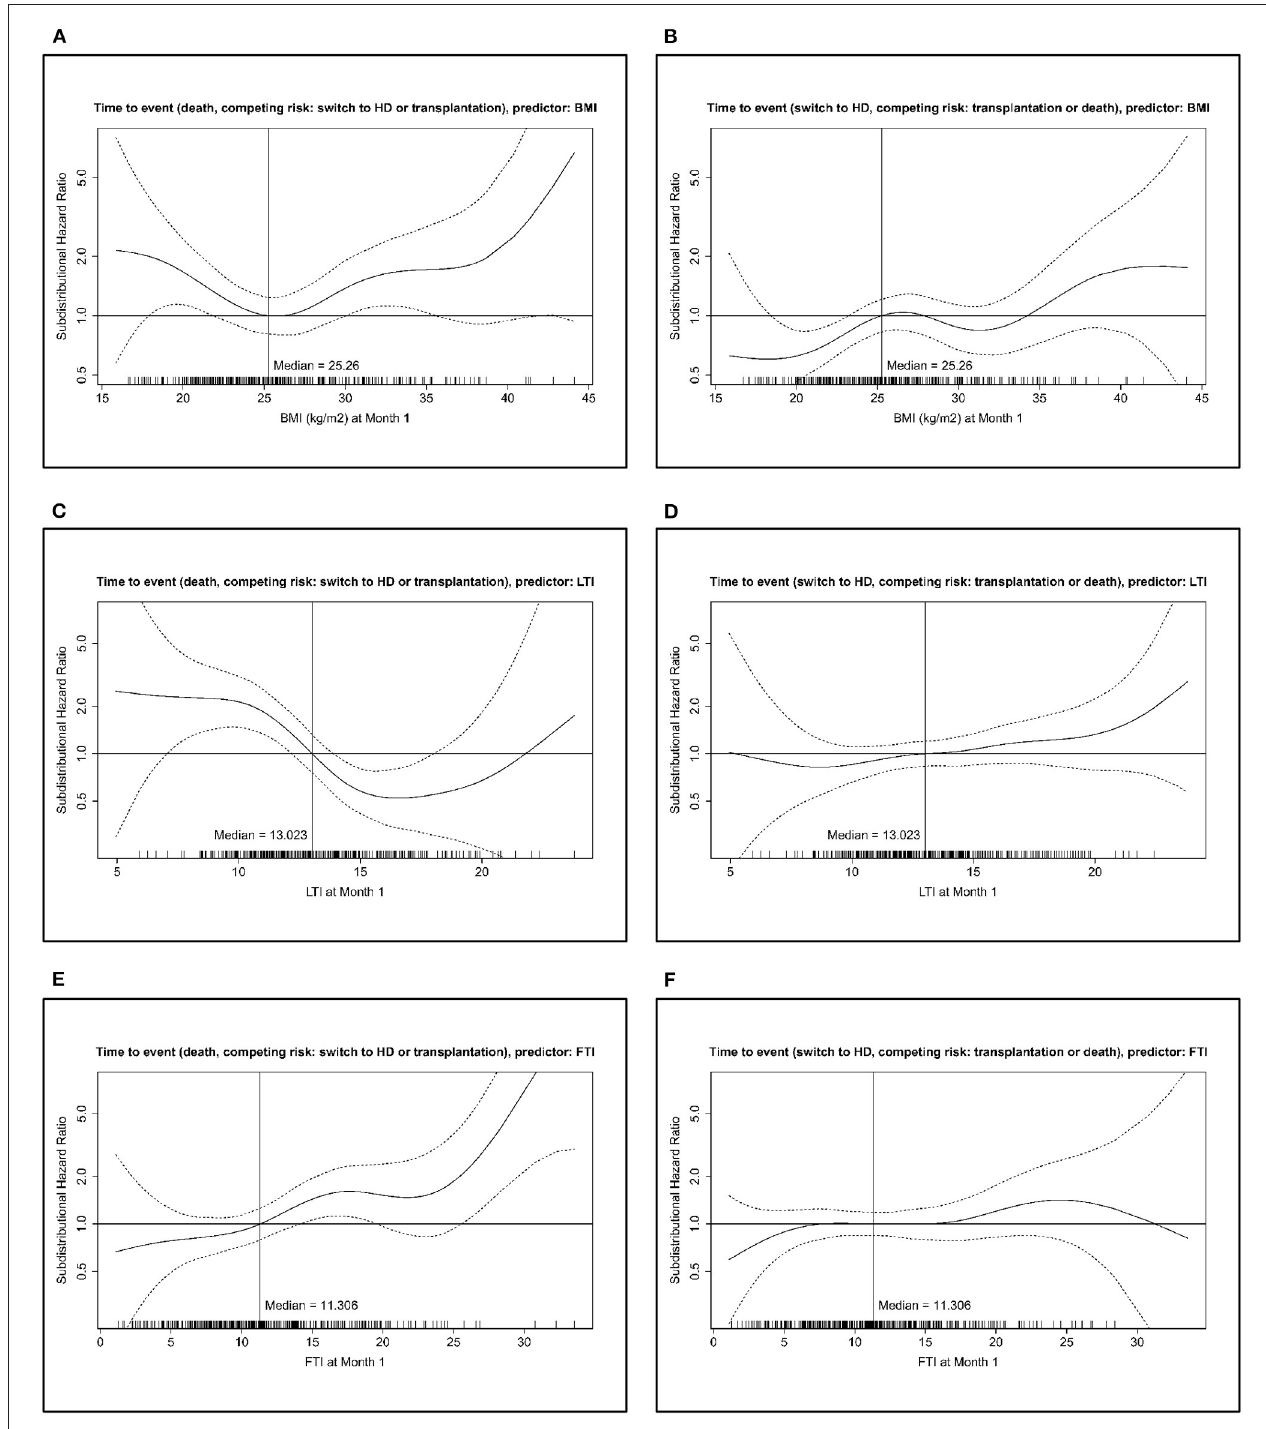
FIGURE 1 | Adjusted spline analysis for the association between body composition and all-cause mortality (left) or change to hemodialysis (HD) (right). Displayed is the subdistributional hazard ratio (HR) and confidence intervals across different BMI (A,B) , lean tissue index (LTI) (C,D) , and fat tissue index (FTI) (E,F) levels. Adjustment was performed for age, gender, comorbidities (diabetes mellitus, cardiovascular disease, liver disease), peritoneal dialysis (PD) modality, and PD solution types.